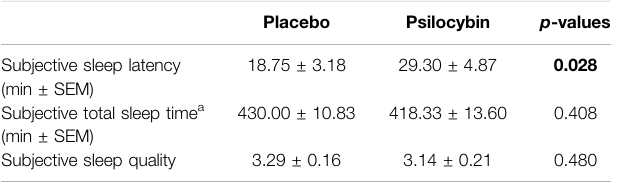
TABLE 2 | Changes in subjective sleep parameters after psilocybin administration (uncorrected).